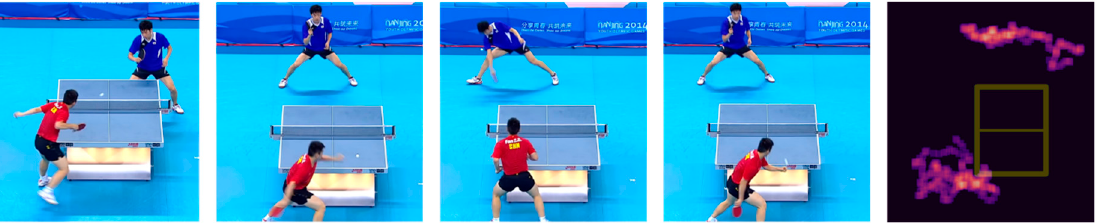
Figure 2. Four frames and their resultant player positions (https://www.youtube.com/watch?v= yRI2Y6ytdPI) (accessed on 7 June